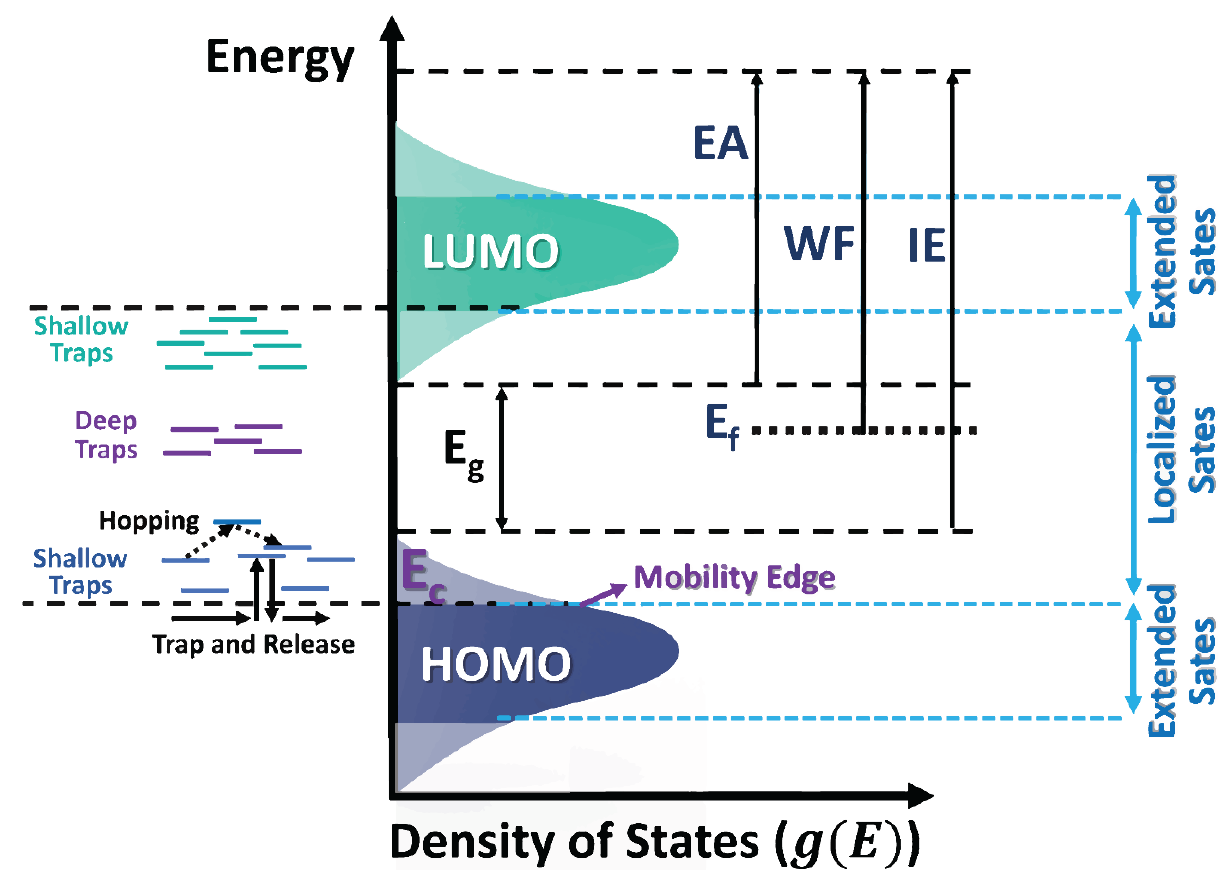
Figure 2. Schematic illustration of energy levels. Some key parameters, such as vacuum-level energy ( E vac ), bandgap ( E g ), Fermi level ( E f ), work function ( WF ), ionization energy ( IE ), and electron affinity ( EA ), are exhibited. Schematic illustrations of extended and localized states are also displayed. The transition from localized states to extended states occurs at the mobility edge. Shallow traps are placed adjacent to the band edges, while deep traps are located at a long distance from band edges. Charge carriers move in the shallow traps via different mechanisms, such as hopping or multiple trapping and release (MTR) [1]. Reproduced with permission [1]. Copyright 2020,